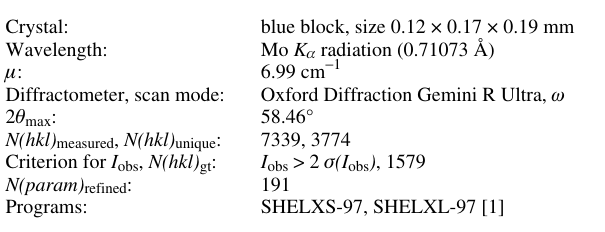
Table 1. Data collection and handling.